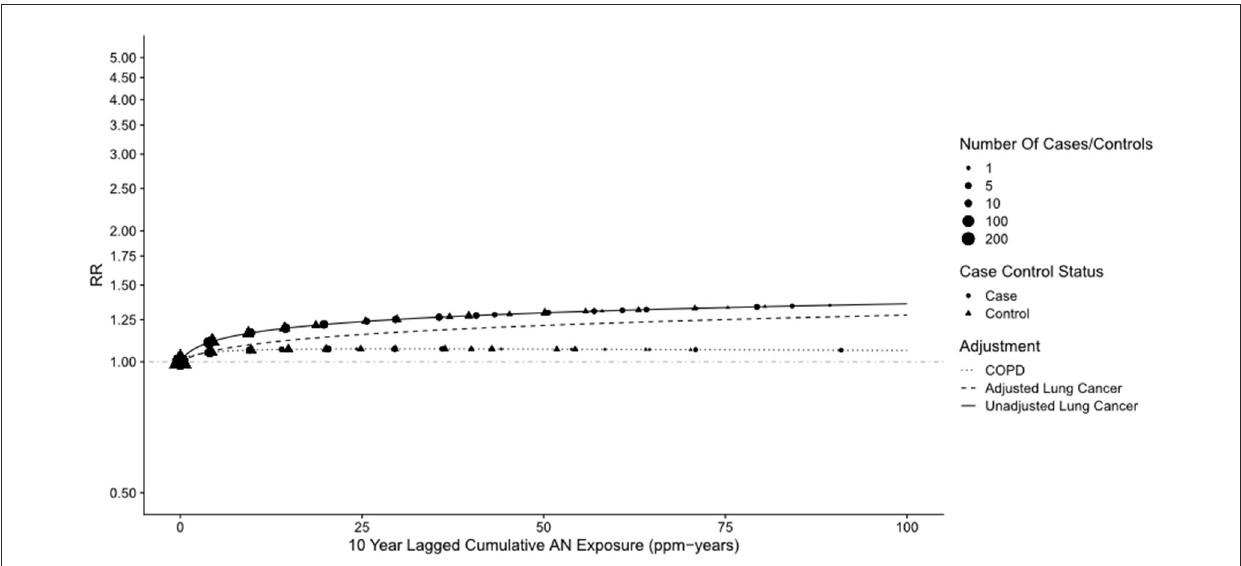
FIGURE4 UPitt lung cancer relative risks (RR) by cumulative AN exposure, unadjusted and adjusted for confounding by smoking (S) and asbestos (A) using the Richardson method.